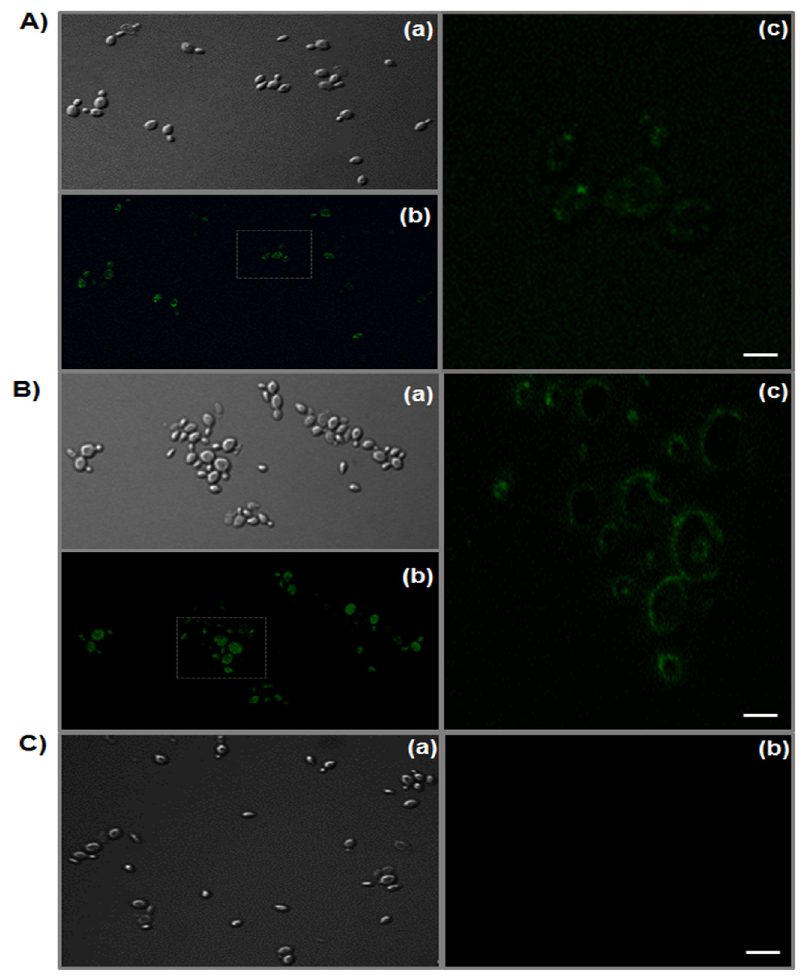
Fig 2. Immunofluorescence microscopy of m Pm Rab7-Ag α 1p and pVP28-Ag α 1p surface displayed by P . pastoris . Methanol induced His + Mut S transformants with (A) m Pm Rab7-Ag α 1p, and (B) pVP28-Ag α 1p grown at 20°C for 96 h and incubated with polyclonal rabbit anti- Pm Rab7 and anti-VP28, respectively. Panel (a) is light microscope, (b) and (c) are fluorescent microscope where (c) is the enlargement of some group of cells in (b). Fluorescence was observed on the cell surface more than in (C) the Ag α 1p control. Bar = 5 μ m, fluorescence magnification = 1,800